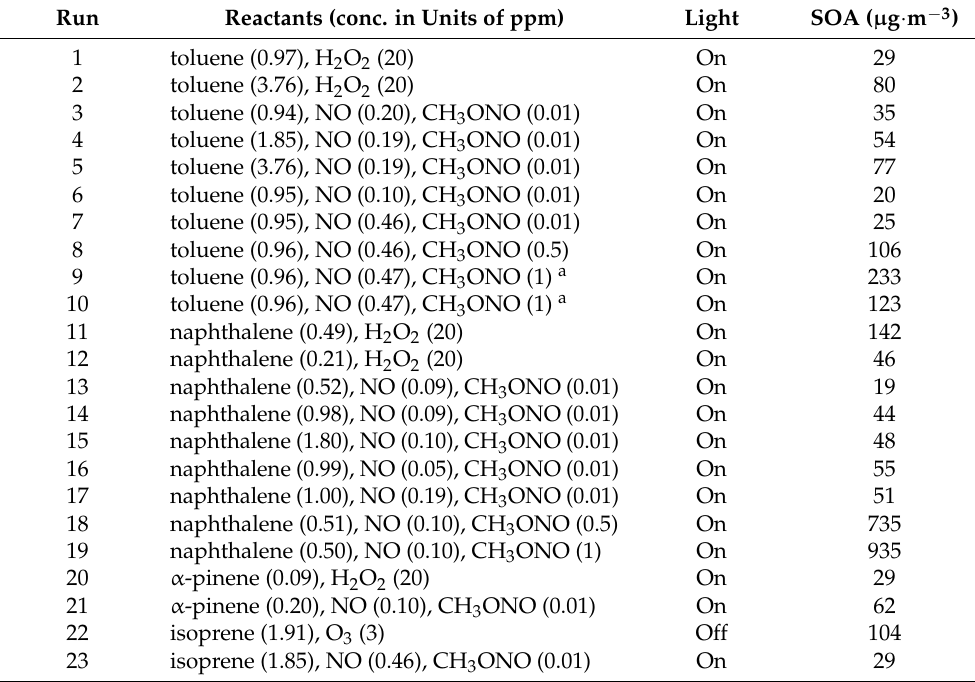
Table 1. Initial concentrations and light conditions, where SOA is secondary organic aerosol. Run Reactants (conc. in Units of ppm) Light SOA ( µ g · m − 3